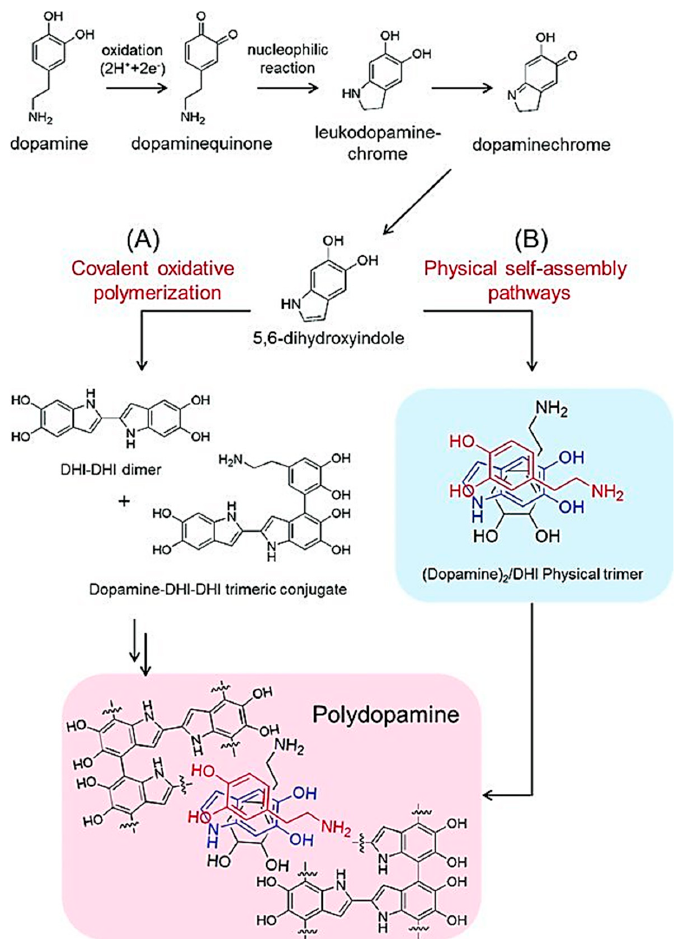
Figure 3. Schematic representation of two pathways hypothesised to occur simultaneously in PDA synthesis. Oxidative polymerisation forming covalent bonds ( A ) and physical self-assembly of reaction intermediates and dopamine ( B ). From reference [42]. Reprinted with permission from Wiley.